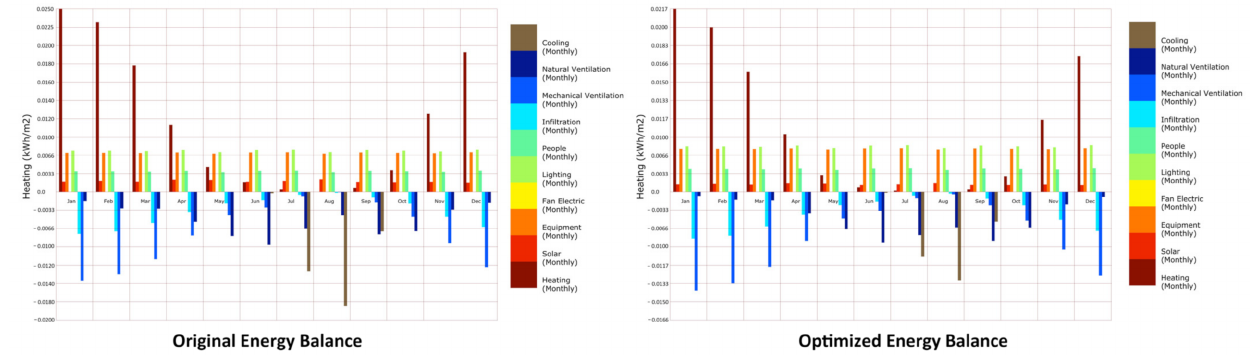
Figure 22. Energy balance comparison of the original (above) and the optimized (below) models.